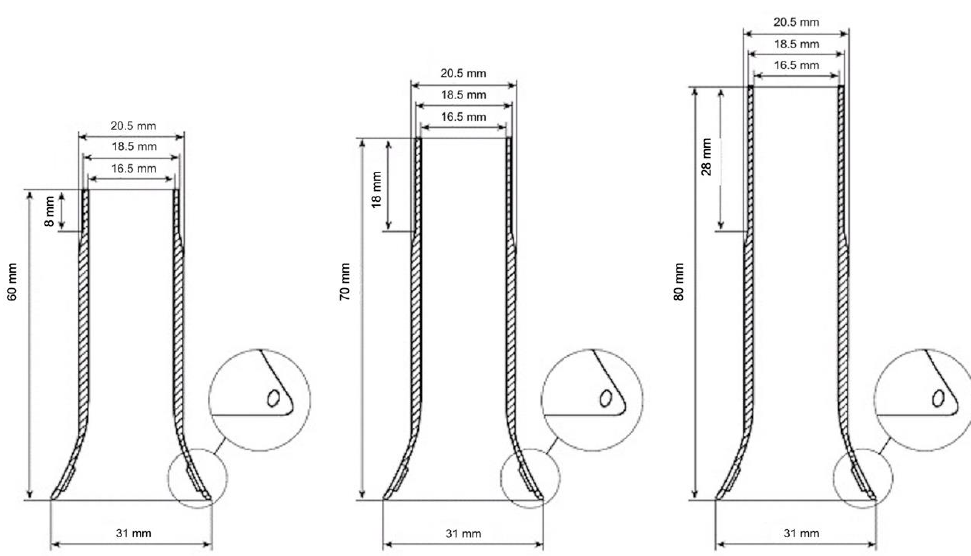
Figure 1. Technical features of the No Coil tube.